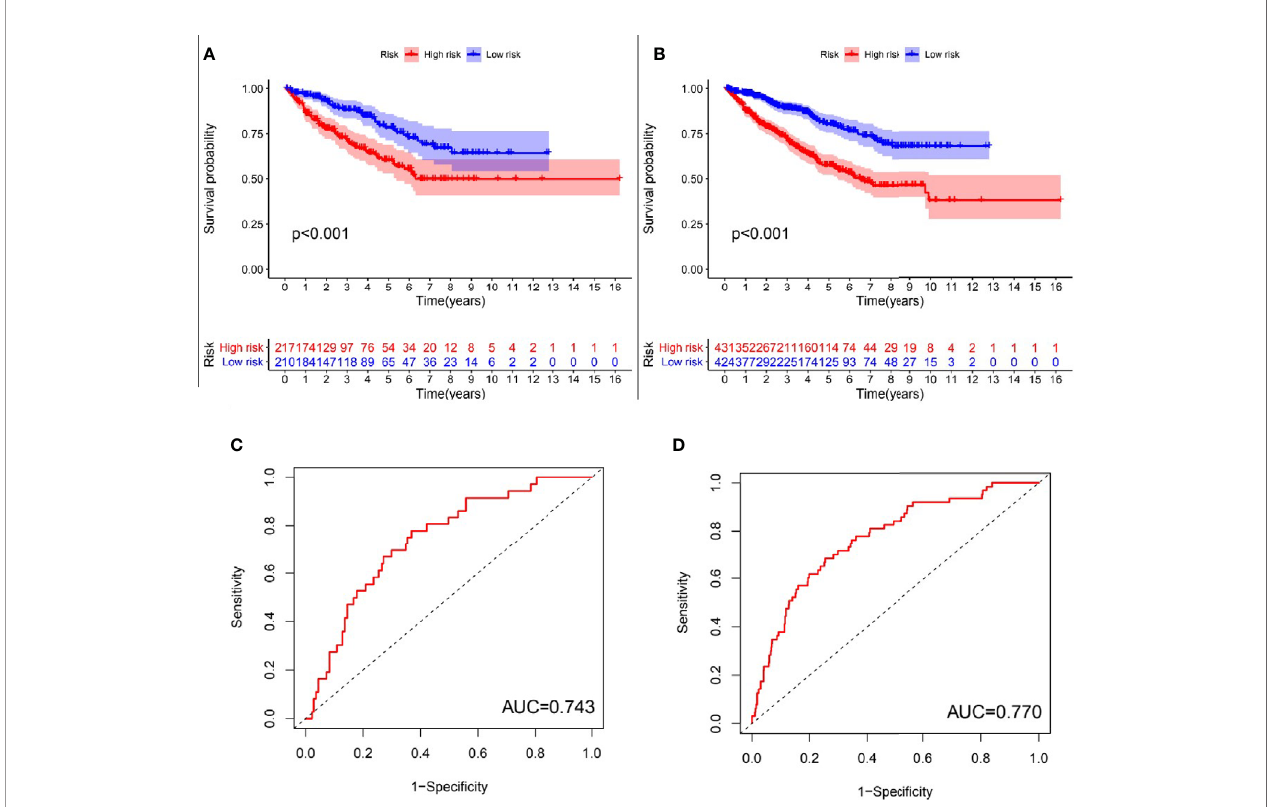
FIGURE 4 | Evaluation of the predictive performance of GInLncSig ’ s for overall survival in patients with RCC. Kaplan-Meier survival curve (A, B) showed that there was signi fi cant difference in the survival rate between the high-risk group and low-risk group in the Test set and TCGA set, respectively (log-rank test, p < 0.05). ROC curves for 1-year survival prediction of the GInLncSig in the Test set (C) and the TCGA set (D) .